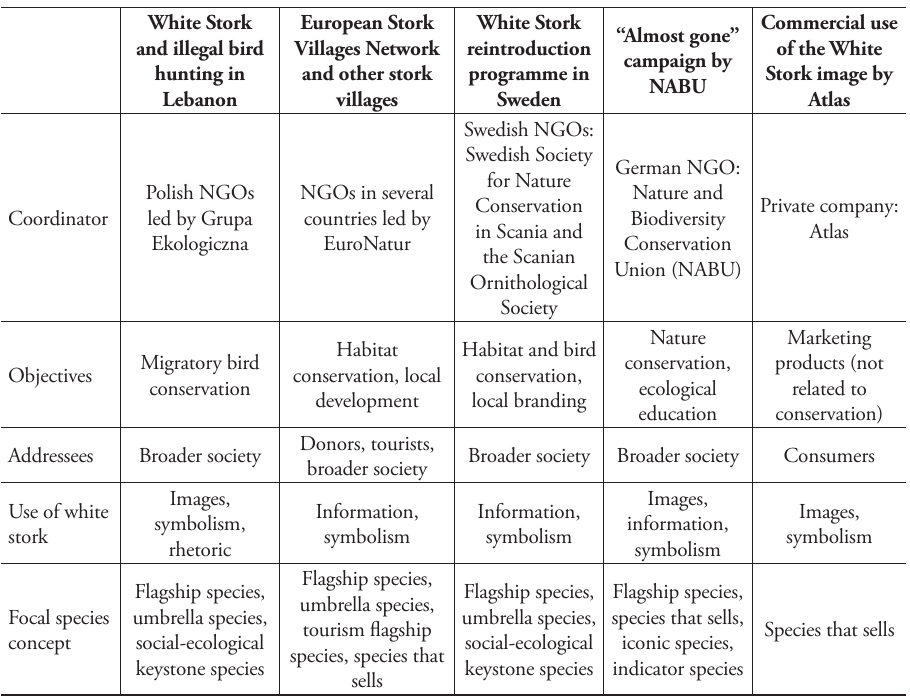
Table 4. Summary of our case